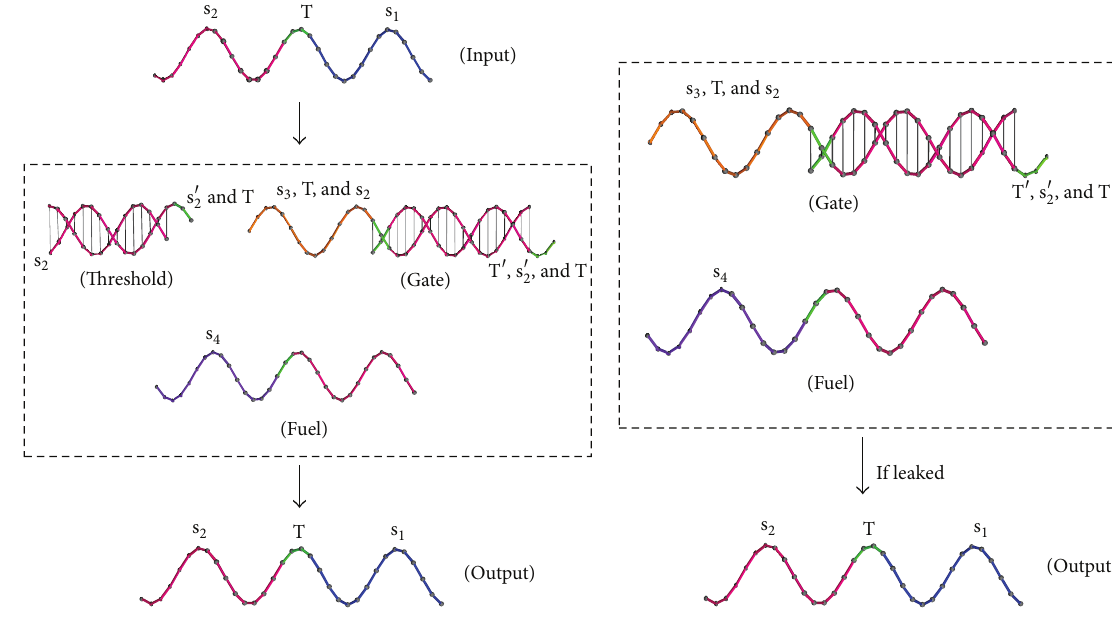
Figure 1: An example of leaky